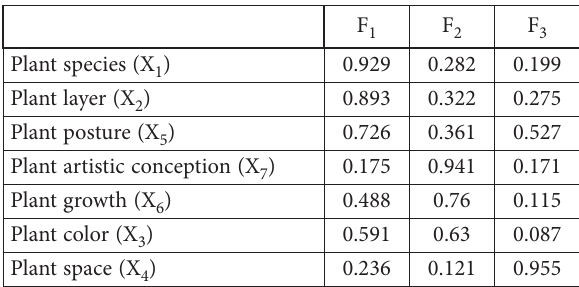
Table 4. Principal factor rotating load matrix